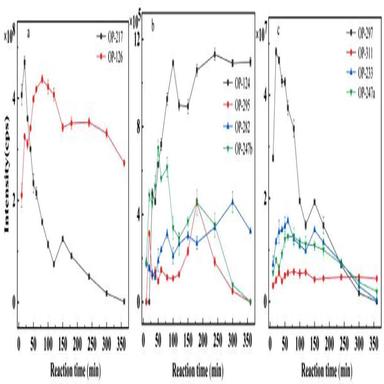
The concentration time frames of the oxidation products over reaction time.